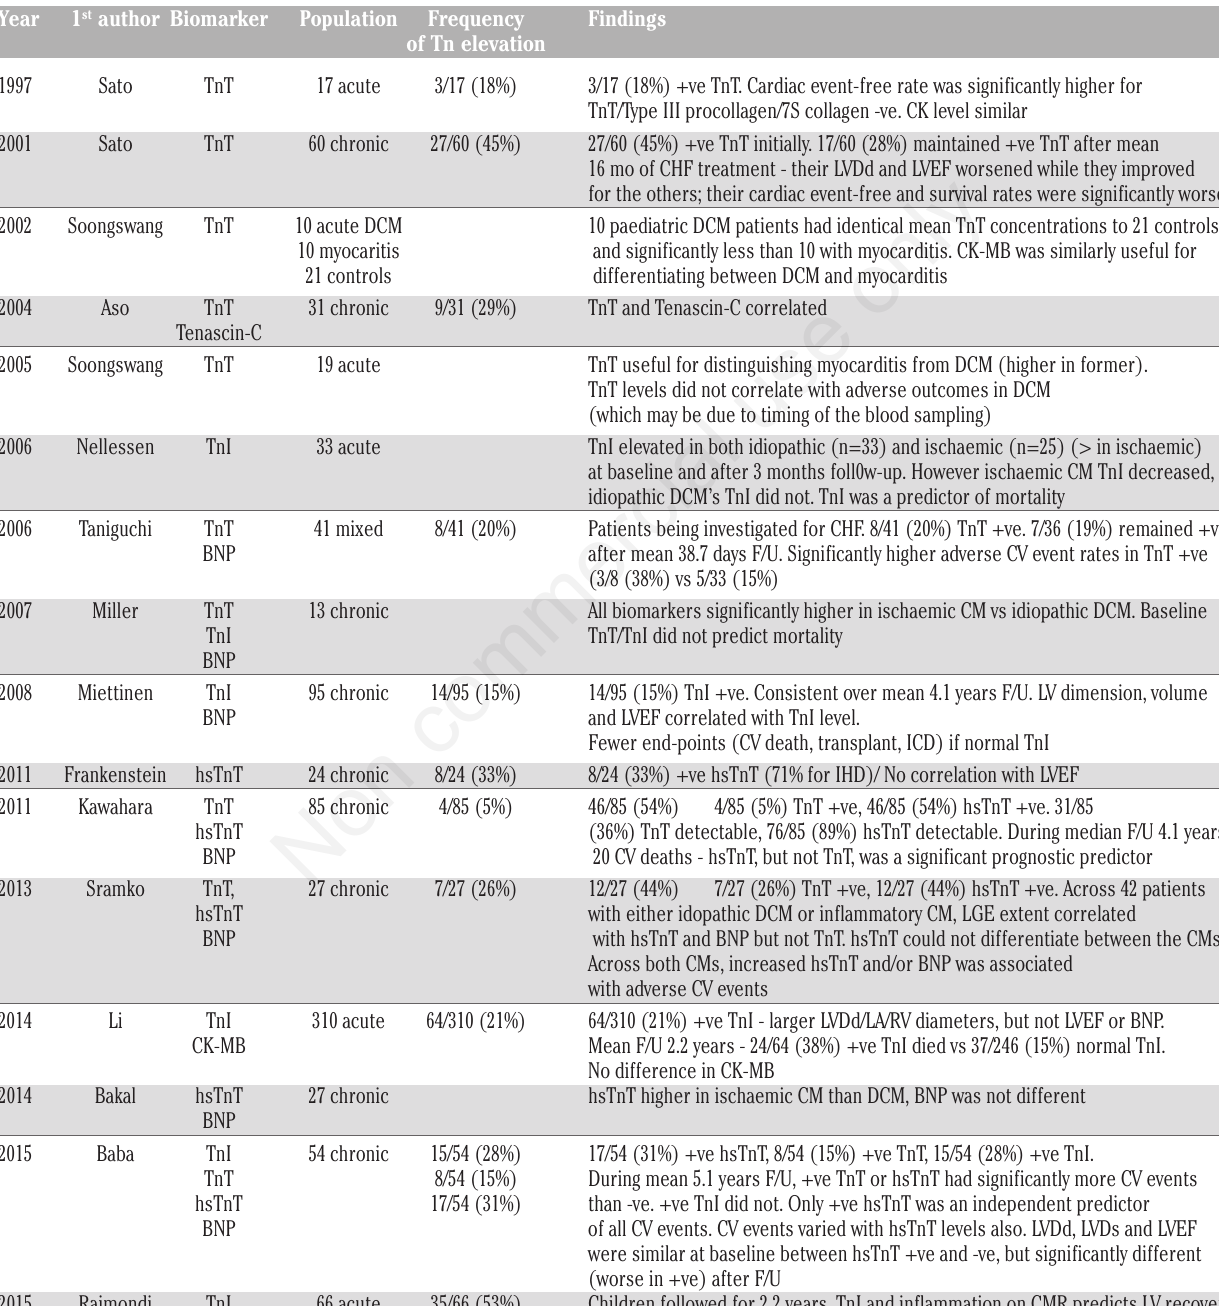
Table 5. Studies evaluating troponin in dilated cardiomyopathy. The study population is described as acute if patients were hospitalised and chronic if patients were stable and enrolled as outpatients.